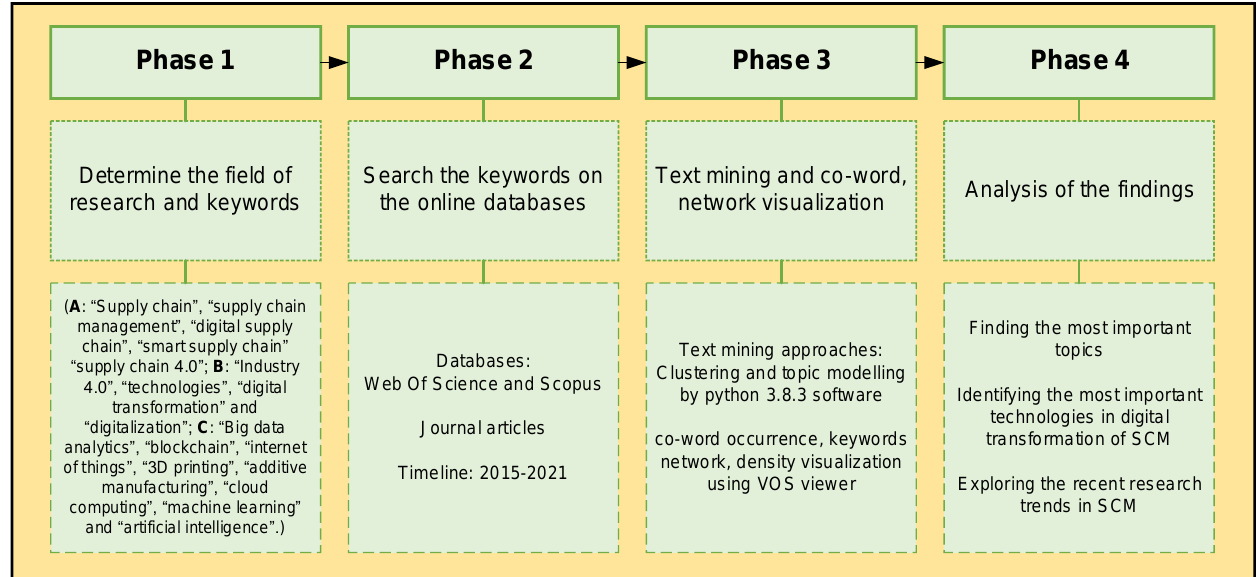
Figure 1. Research process.